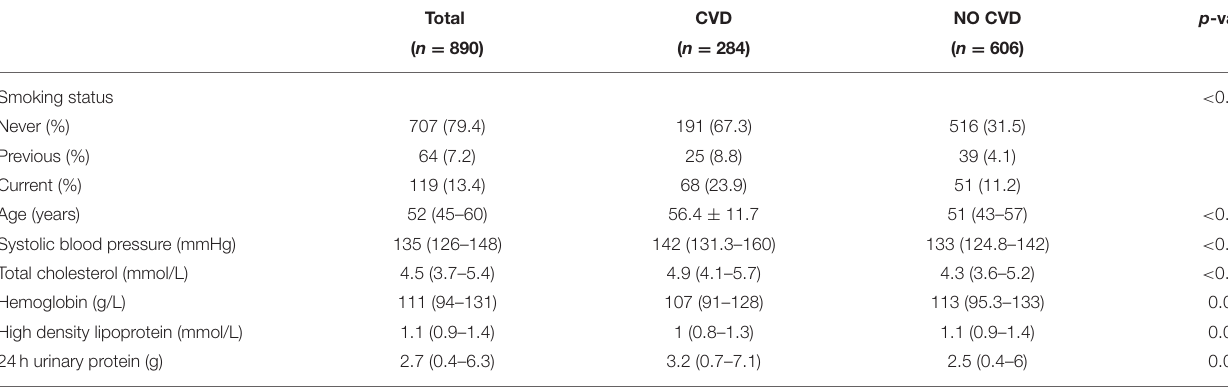
TABLE 2 | Demographic and clinical characteristics of patients with or without CVD in the